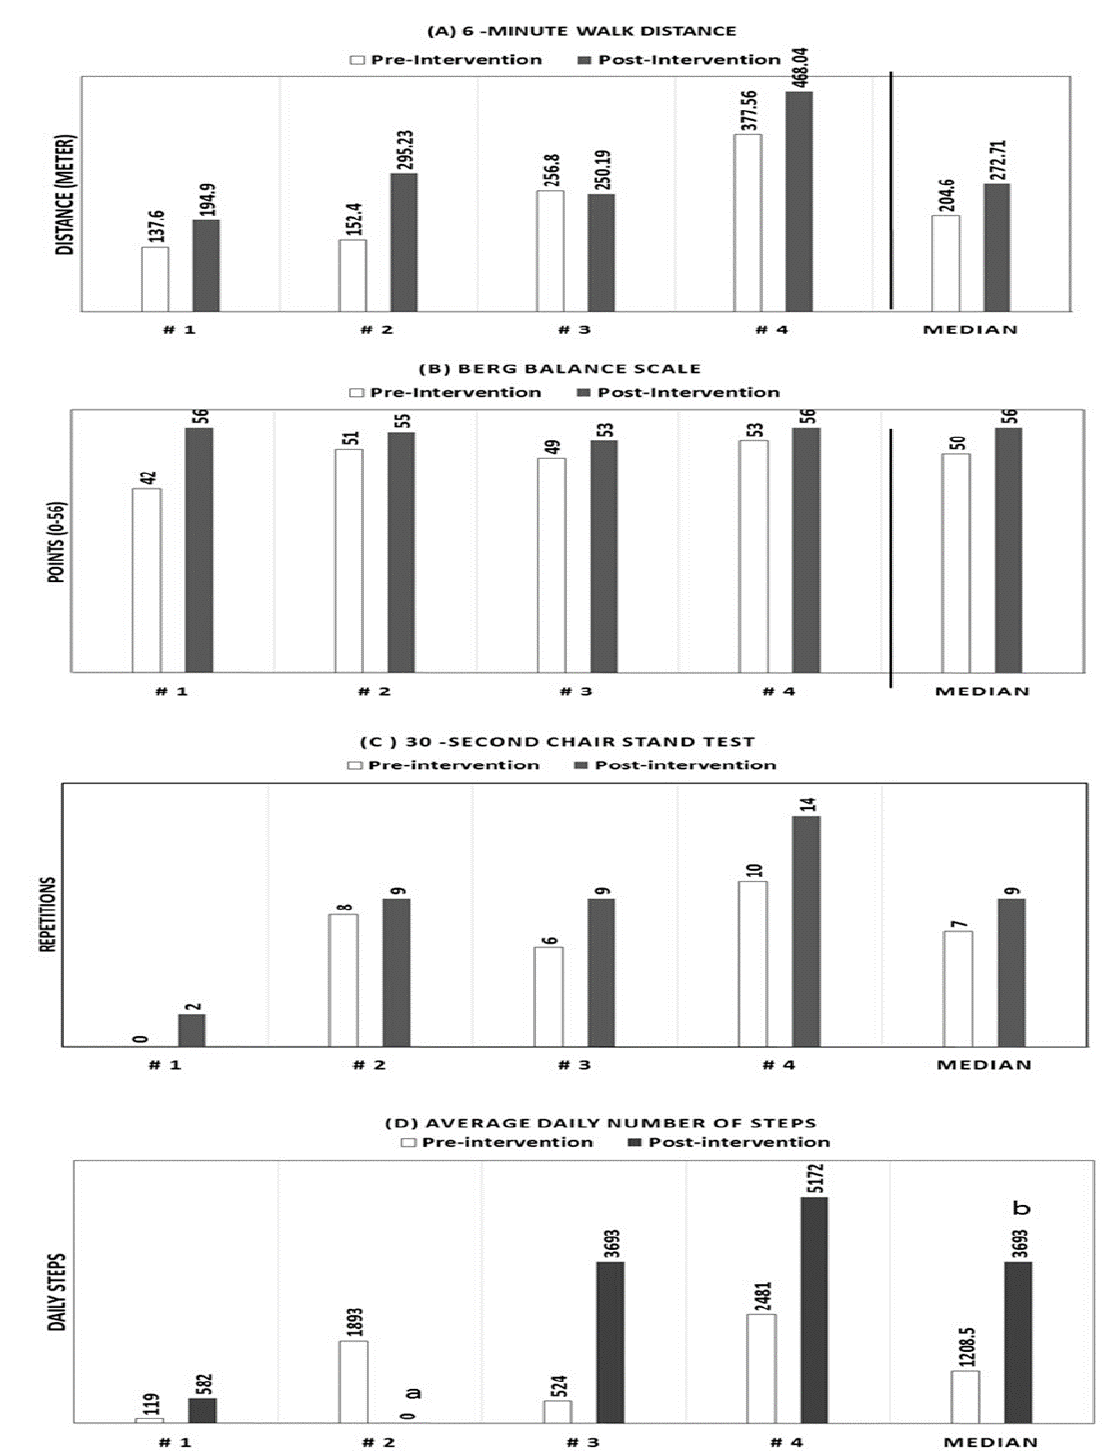
Figure 2. Measures of physical function and physical activity pre- and post- intervention (N=4) (B) Berg Balance Scale, Possible score range 0-56. Higher score indicate better balance. a Missing data (Participant did not wear the armband); b n=3 due to missing